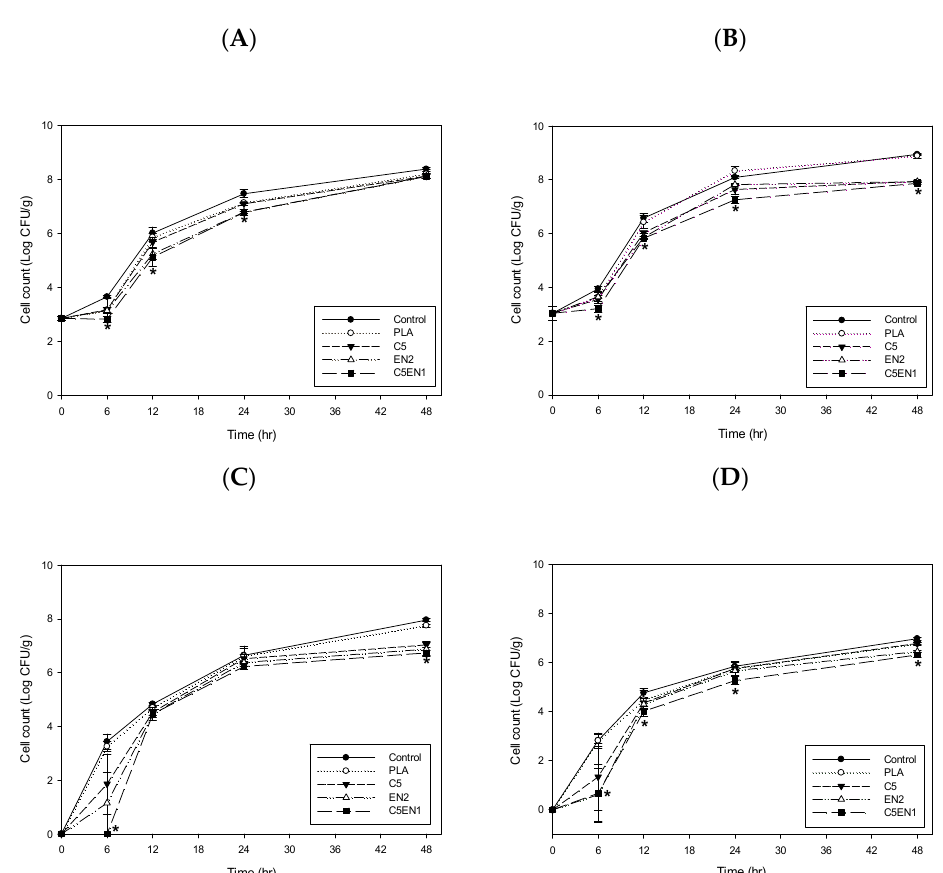
Figure 5. Changes in cell counts of coliforms ( A ), Aeromonas ( B ), Pseudomonas ( C ) and Vibrio ( D ) in fish fillet ( Epinephelus fuscoguttatus × Epinephelus lanceolatus ) covered with PLA, C5, EN2, or C5EN1 film during storage at 25 °C for 48 h. PLA, PLA film as control; C5, PLA + 0.5% chitosan; EN2, PLA + 20 mM EDTA + 0.02% nisin; C5EN1, PLA + 0.5%chitosan + 20 mM EDTA + 0.01%nisin. Data are